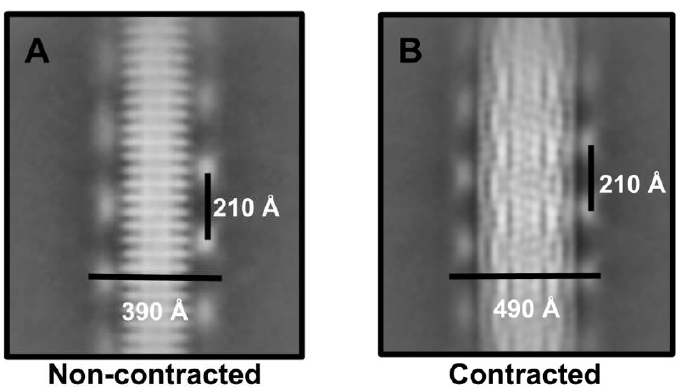
Figure 4. Phage G outer coil density in 2D classification. Density from the outer coil was observed in phage G sheaths that were ( A ) non-contracted, and ( B ) contracted. In both sheath states, the outer coil had the same measured axial pitch distance (210 Å).